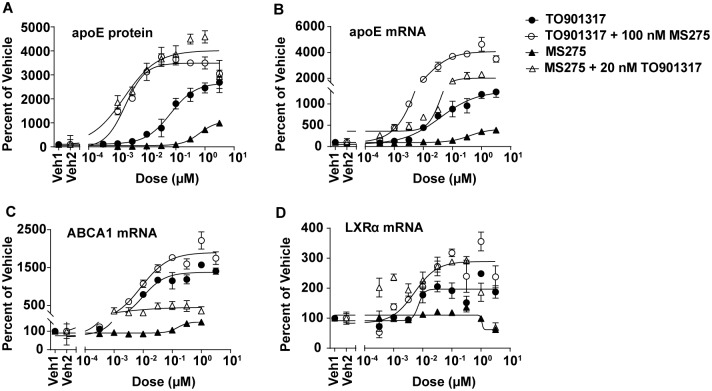
A pan class I HDAC inhibitor works synergistically with a pan LXR agonist on the expression of apoE but not ABCA1 or LXR.Treatment of TO901317 (●), MS275 (▲) or co-treatment of the compounds (TO901317 + 100 nM MS275 (o) or MS275 + 20 nM TO901317 (Δ)) on the levels of secreted apoE protein (A), and the levels of apoE mRNA (B), ABCA1 mRNA (C), and LXRα mRNA (D) in CCF-STTG1 cells. For co-treatment, the amount of apoE protein and apoE, ABCA1, and LXRα mRNA levels were normalized to vehicle treated controls (Veh1) and the effect of the constant compound (100 nM MS275 or 20 nM TO901317, denoted Veh2) was subtracted out after normalization. The average of GAPDH and 18S mRNA were used as endogenous controls for normalization of mRNA levels. See S3 Table for gene expression assays. All data are represented as values ±SEM.